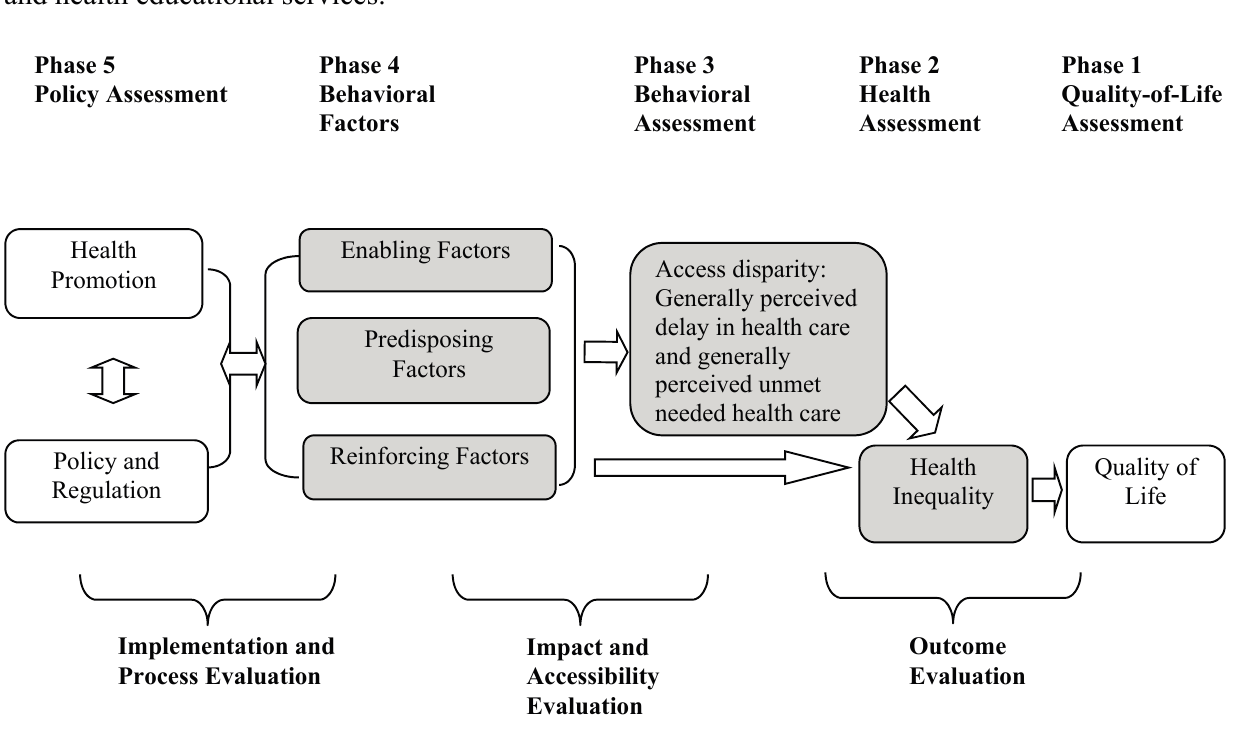
Figure 2. Application of PRECEDE-PROCEED Model to examine generally perceived delay in health care and generally perceived unmet needed health